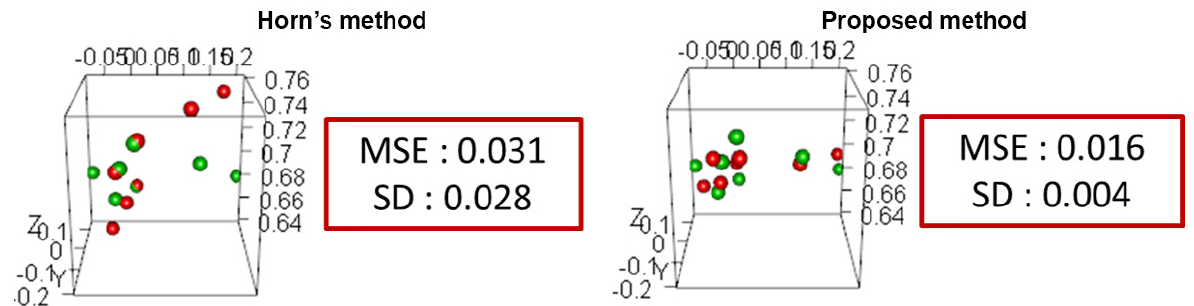
Figure 11. Comparison of the relative pose estimation methods using a set of vSLAM map points. Table 3. Comparison of the relative pose estimation methods. Quaternions Calculated from a Set of vSLAM Map Points. Quaternions Calculated from a Set of Ideal Points.